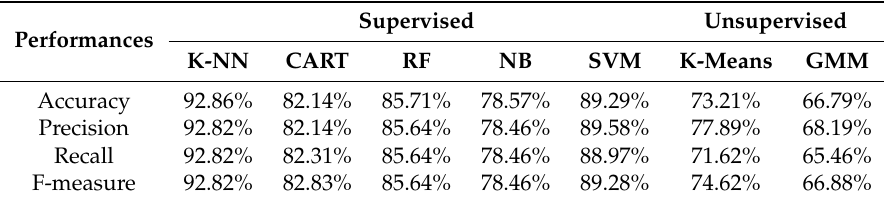
Table 12. Accuracy, Precision, Recall and F-measure for each classifier, obtained from the binary classification between PD and ALS subjects.